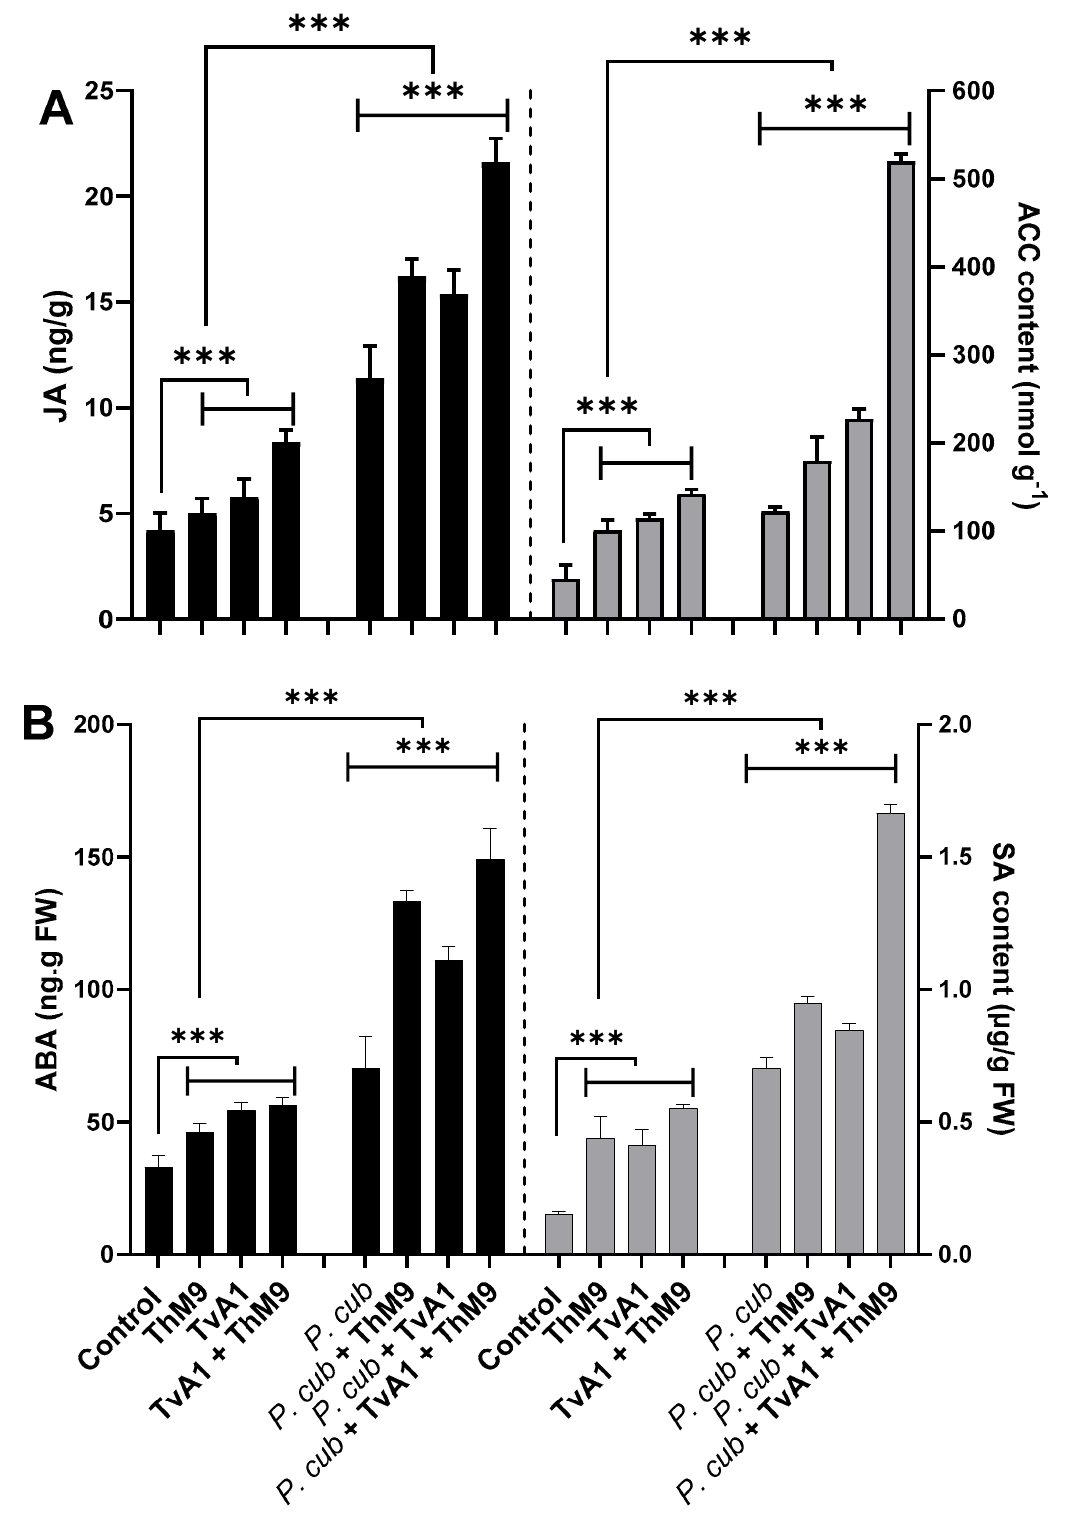
Figure 8. Effect of the fungal isolates (ThM9 and TvA1) and pathogen ( P. cubensis ) co-inoculation on phytohormonal content in luffa leaf ( A ) JA (left axis), ACC contents (right axis). ( B ) ABA (left axis), SA (right axis). Quantitative data represent the means ± SD (n = 12) of three independent experi- ments. The asterisks indicate a significant difference between treated samples compared to control (*** p ≤ 0.005). FW, fresh weight.